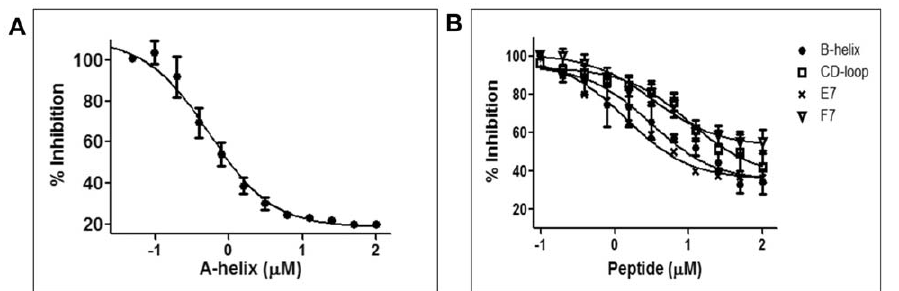
Figure 5. Floppy F-helix sensitizes the proteasome for the presence of substrate and the interaction is reinforced by N-terminal helices. Overlapping peptides panning the entire length of myoglobin were tested for binding to the immobilized proteasome by ELISA. (A) A-helix peptide which bound strongly to the proteasome was tested for its ability to compete with apoMb. This peptide brought about 80% inhibition at 3 m M concentration. (B) The B-helix, CD-loop, E7 and F7 peptides which share sequences with the floppy F-helix also inhibited the binding of apoMb. However they were considerably less potent than the A-helix peptide. All incubations were done in the presence of 100 nM MG132. Data represent mean values of at least three independent 6 S.D. For E7 S.D. is not plotted for